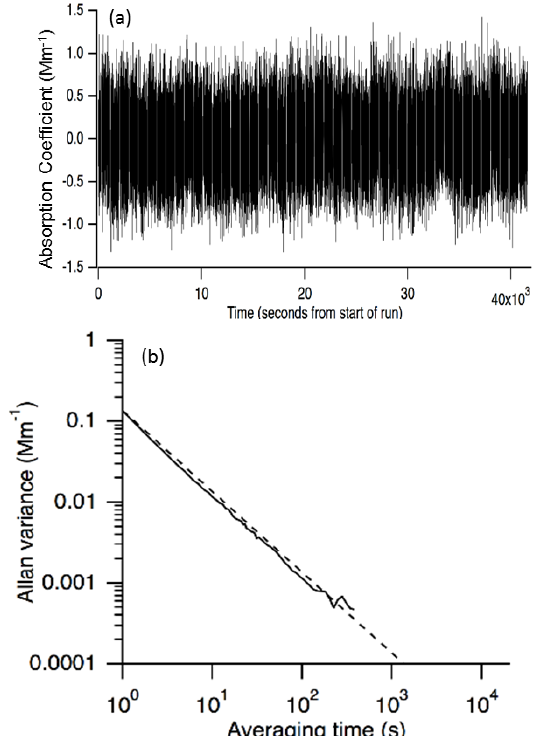
Figure 3. Background-corrected absorption coefficients (a) and Al- lan variance (b) measured by an 870nm PAX sampling filtered lab- oratory air overnight in a temperature-controlled environment. The dashed line in (b) gives the variance for white